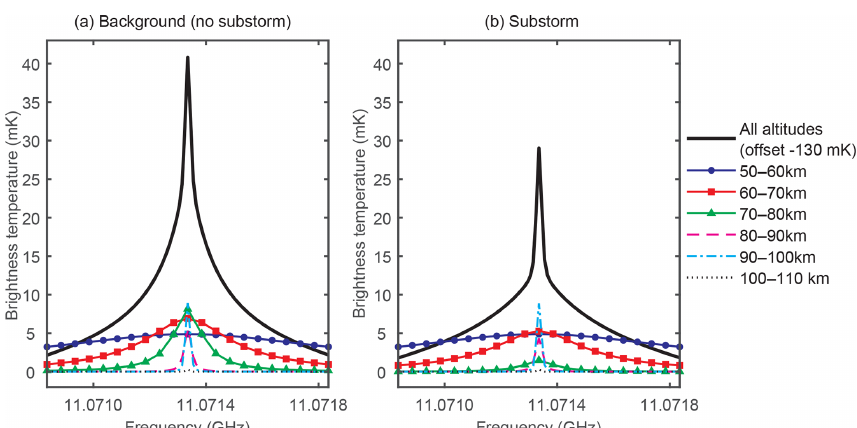
Figure 6. Simulated atmospheric spectra for the ozone (O 3 ) 11.072GHz emission line in clear-sky December conditions using a ground- based radiometer with 10kHz frequency resolution, 82 ◦ zenith angle, and 0 ◦ azimuthal angle located at Kilpisjärvi (69 ◦ 03 (cid:48) N, 20 ◦ 48 (cid:48) E), Finland. Black solid curves show the overall OH emission from all altitudes. Coloured lines show the contributions from 10km altitude intervals in the range 50–110km. Panels (a) and (b) show the spectra for background (no substorm) and substorm conditions